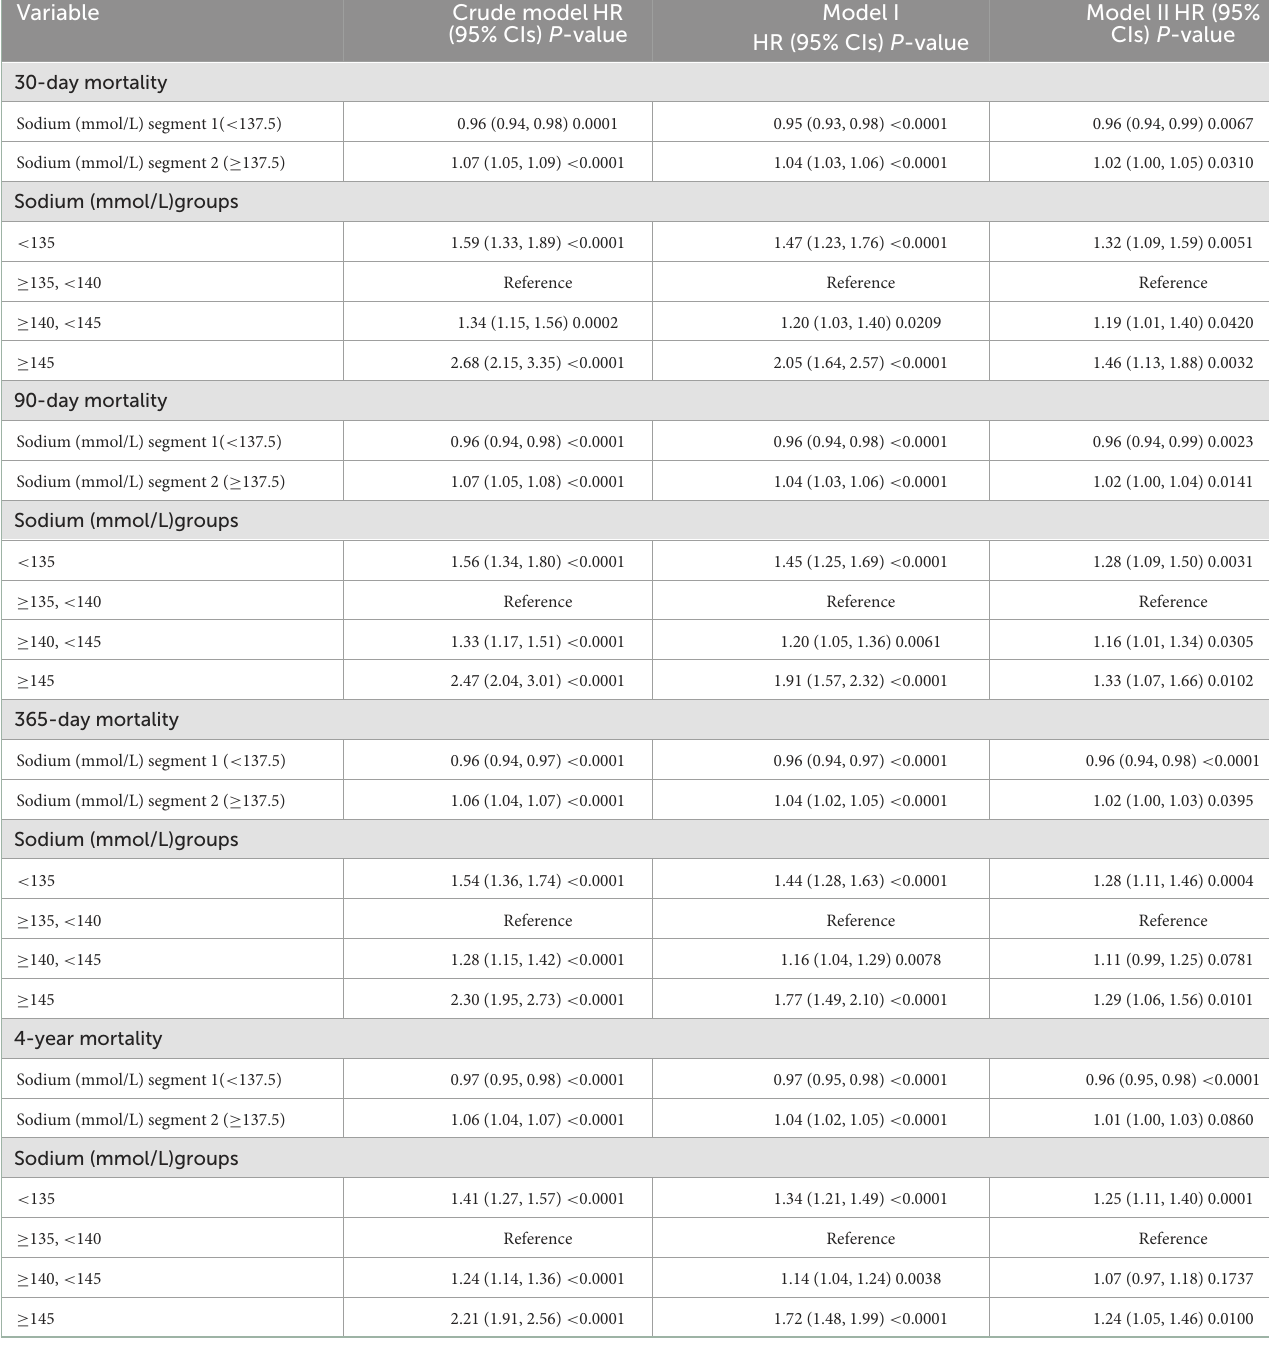
TABLE 3 Association of sodium with mortality.